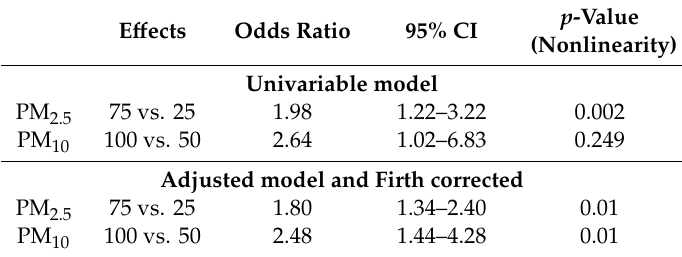
Table 3. Estimated e ff ects of pollutants on atrial burden.